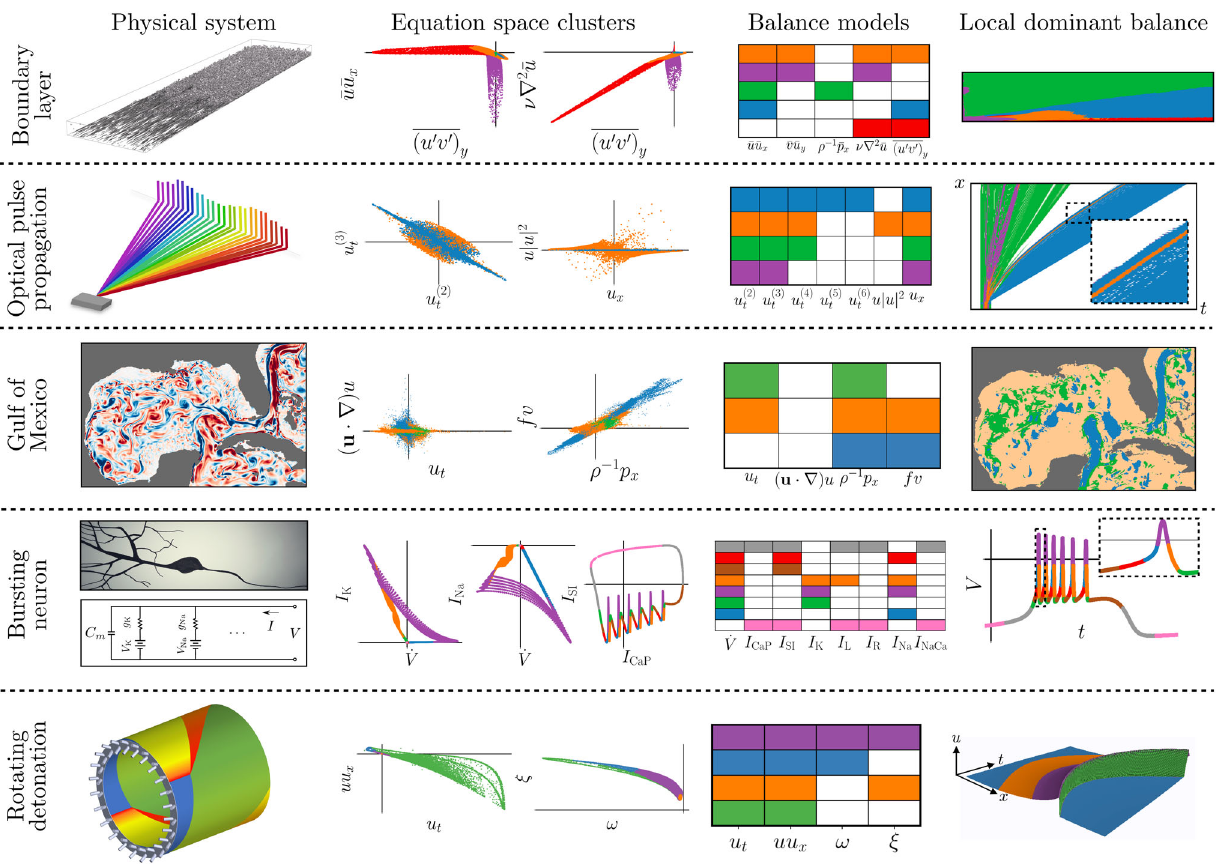
Fig. 2 Dominant balance physics identi fi ed across a range of systems. For each case, a visualization of the system is shown on the left, followed by 2D views of the equation space colored by the identi fi ed balance relation, a key describing the active terms in each model, and the original fi eld colored by the local balance. From top: a boundary layer in transition to turbulence, pulse propagation in an optical fi ber, surface currents in the Gulf of Mexico, a Hodgkin – Huxley model for an intrinsically bursting neuron, and a simpli fi ed combustion model for a rotating detonation